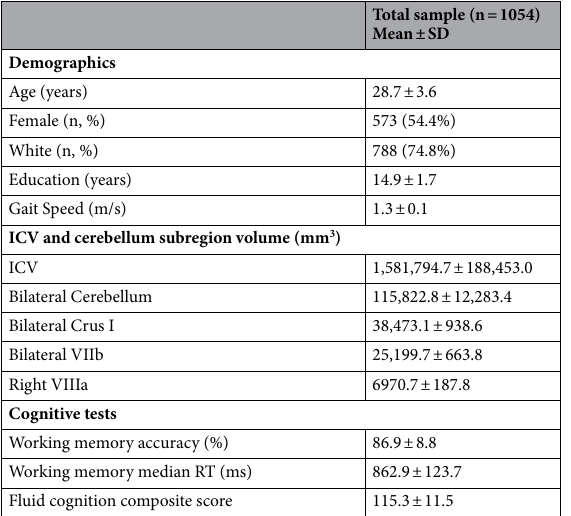
Table 1. Demographics data of the participants. SD, standard deviation; ICV, total intracranial volume; RT, response